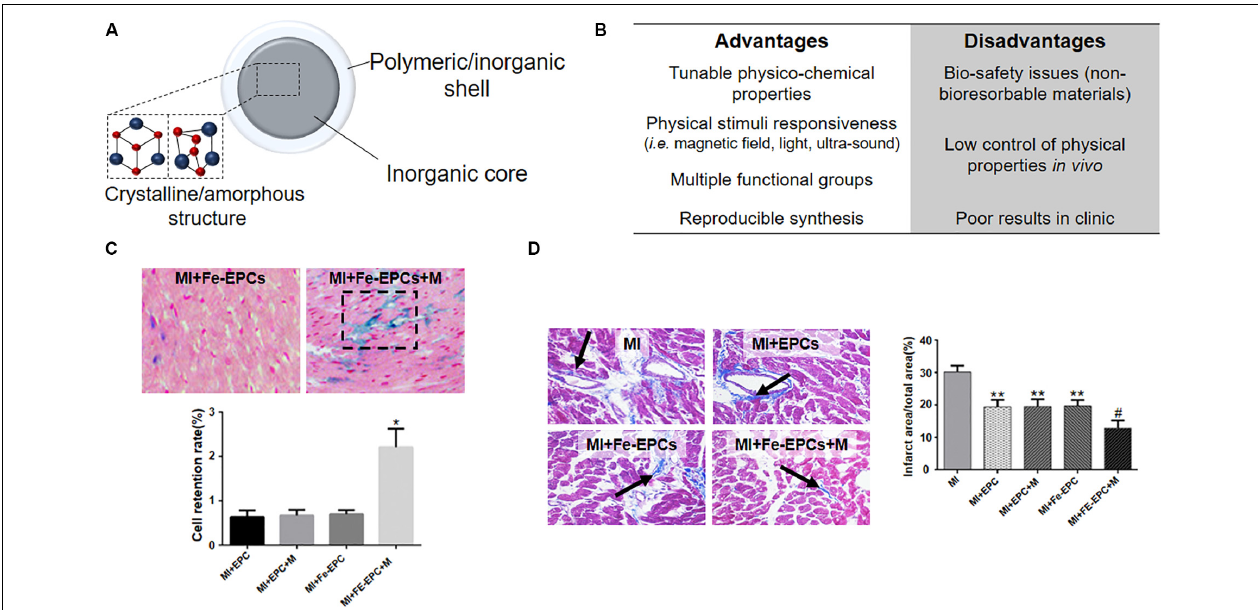
FIGURE 7 | Inorganic NPs for cardiac regeneration. (A) Schematic representation of inorganic NPs used for cardiac regeneration. (B) Table listing the advantages and disadvantages associated with the use of inorganic nanoparticles. (C) Representative hematoxylin/eosin (cell nuclei and cytoplasm) and Prussian blue (iron oxide nanoparticles) images of infarcted myocardium (MI) injected with endothelial progenitor cells loaded with iron oxide nanoparticles (Fe-EPCs) and exposed (+M) or not to external magnetic field. The graph quantifies the retention of EPCs and Fe-EPCs in the presence or not of magnetic field * p < 0.05. (D) Representative Masson’s trichrome staining of infarcted myocardium (MI) injected with endothelial progenitor cells loaded (Fe-EPCs) or not (EPCs) with iron oxide nanoparticles and exposed (+M) or not to external magnetic field. Blue color and black arrow identify the fibrotic area. The graph quantifies the infarction area as obtained by image analysis. * p < 0.05 versus the control Sham operated group (not shown), # p < 0.05 versus the other group shown in the graph. Reprinted and adapted from: (C,D) (Zhang et al., 2019) with permission of